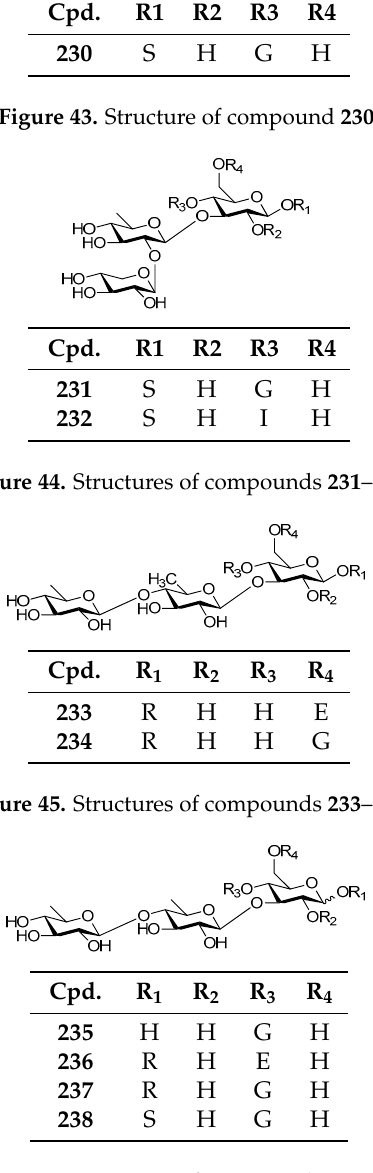
Figure 46. Structures of compounds 235 – 238